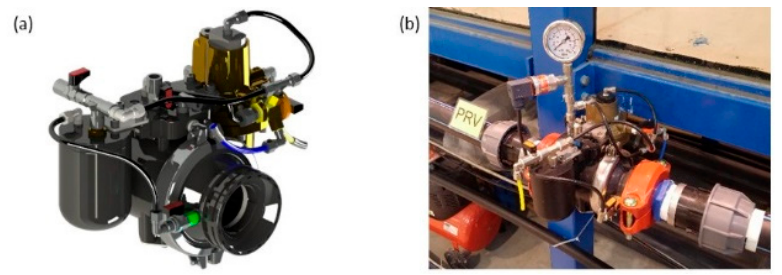
Figure 1. ( a ) The piston-actuated pressure-reducing valve (PA-PRV) with mechanical pilot; ( b ) the device installed in the hydraulic system. Water 2020 , 12 , x FOR PEER REVIEW